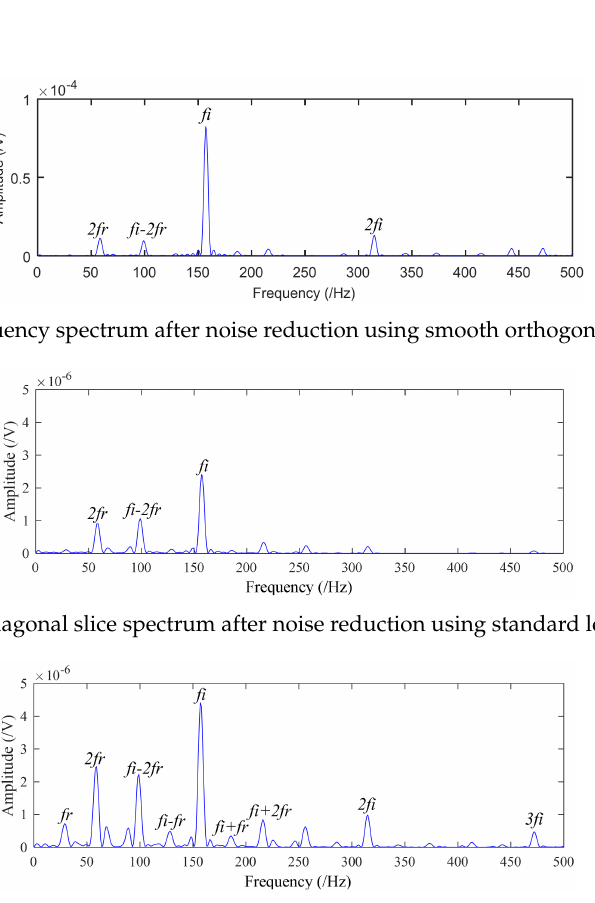
Figure 21. The diagonal slice spectrum after noise reduction using multiscale local projection.